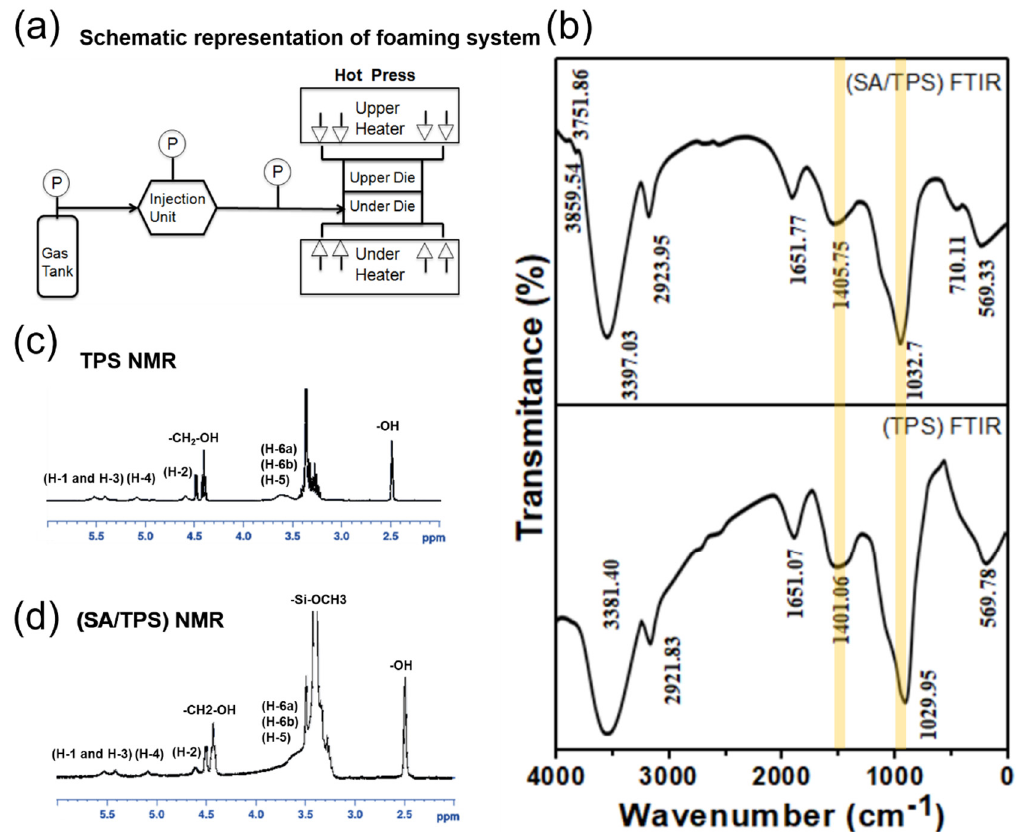
Figure 1. Schematic representation of foaming system and chemical modification for analysis of TPS functional group. ( a ) The processing system is used for CO 2 batch foaming. ( b ) FT-IR of TPS and (SA/TPS). ( c , d ) NMR of TPS and (SA/TPS).